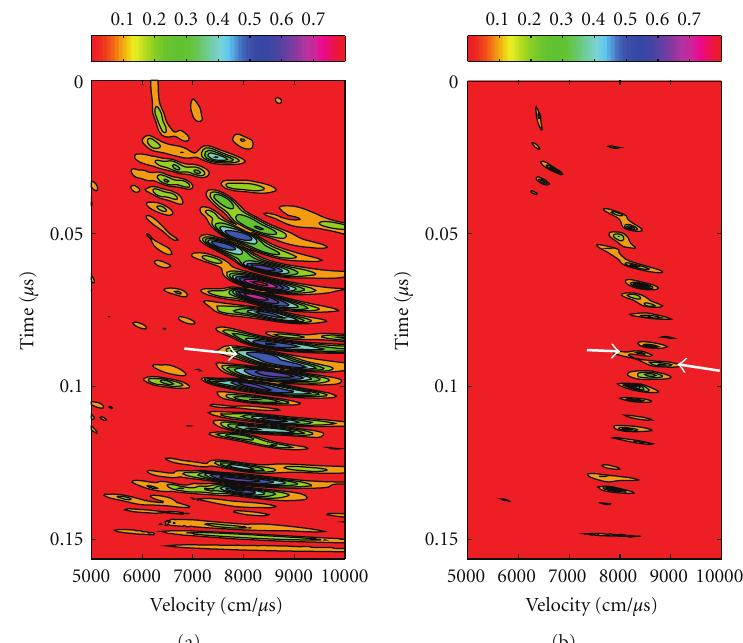
Figure 11: Velocity spectra obtained employing, respectively, semblance (a) and SB-MUSIC (b). The white arrows indicate the apparent single event associated with semblance and the corresponding two events computed from SB-MUSIC.